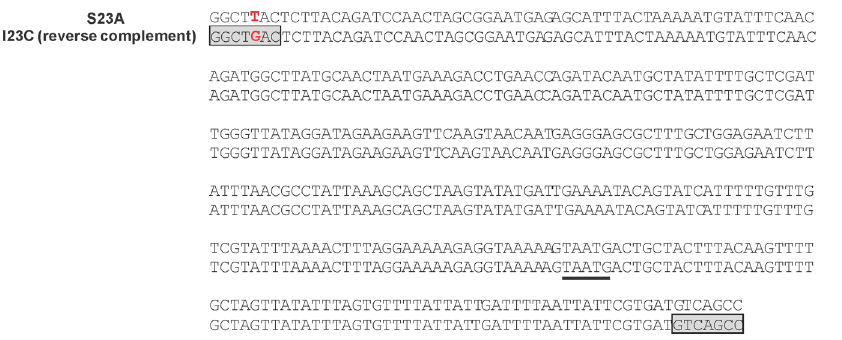
Figure 2. Nucleotide sequences of regions in S23A (upper line) and I23C (lower line) affected by the 353-bp inversion. The stop codon of ORF17 and the overlapping start codon of ORF18 are underlined. The functions of ORF17 and ORF18 have not been defined but both are necessary for the expression of serotype b strain [28]. The displayed sequence of strain S23A is 100% identical to the comparable region in strain Y4 [28]. The single nucleotide mutation in strain I23C is marked red. The resultant 7-base inverted repeats in strain I23C are boxed and shaded.